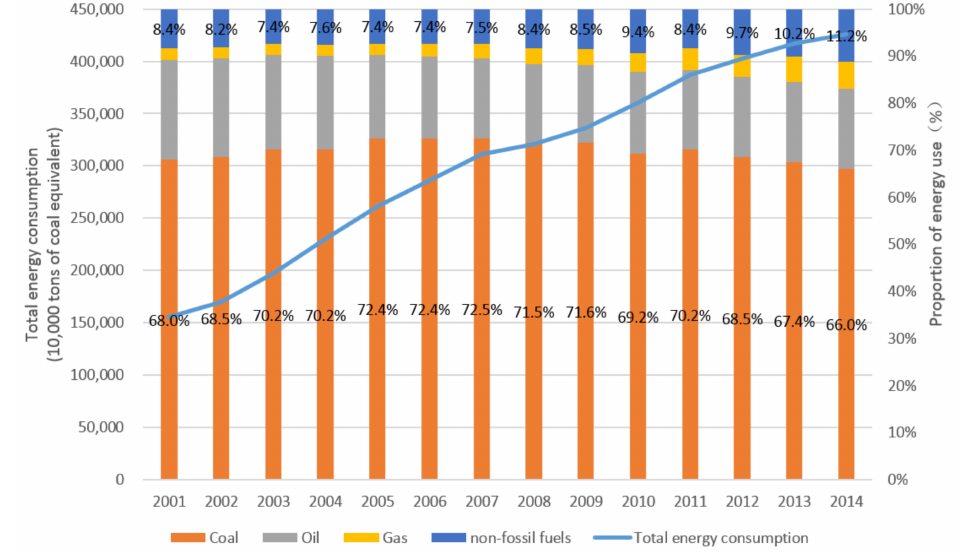
Figure 6. The Changes in China’s Energy Structure Between 2001–2014